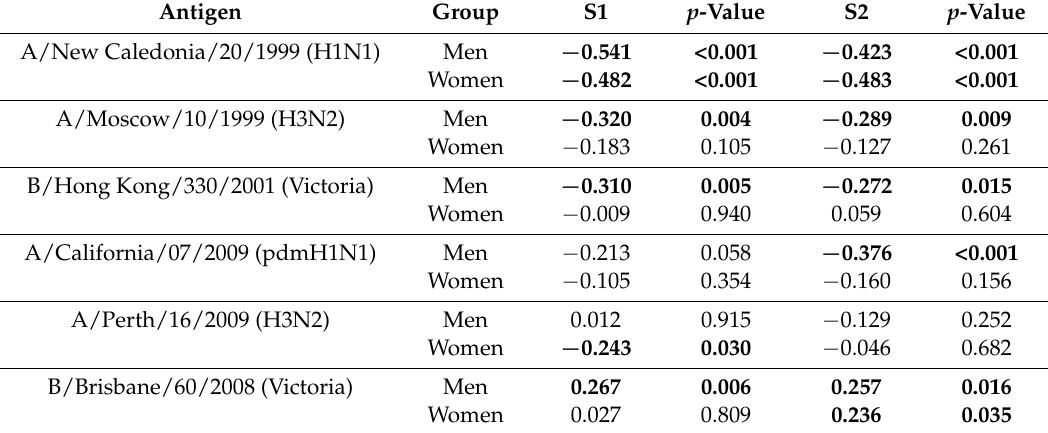
Table 4. Correlations between Age and HI Titer. The names of the antigens used in the HI assay are listed in the first column, the 2003 cohort was assayed with the antigens from 1999 to 2001 and the 2011 cohort was assayed with antigens from 2008 to 2009. The Spearman rank correlation coefficient for age and each blood draw, S1 or S2, is shown. The results are in bold where the p -values are less than 0.05. Antigen Group S1 p -Value S2 p -Value A/New Caledonia/20/1999 (H1N1) Men − 0.541 <0.001 − 0.423 <0.001 Women − 0.482 <0.001 − 0.483 <0.001 A/Moscow/10/1999 (H3N2) Men − 0.320 0.004 − 0.289 0.009 − 0.183 0.105 − 0.127 0.261 B/Hong Kong/330/2001 (Victoria) Men − 0.310 0.015 Men − 0.213 − 0.376 <0.001 −